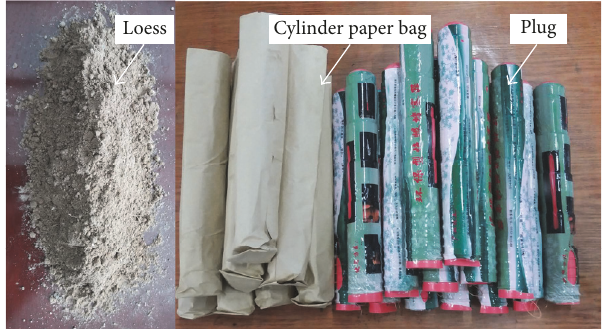
Figure 5: Test samples in the blocking impact